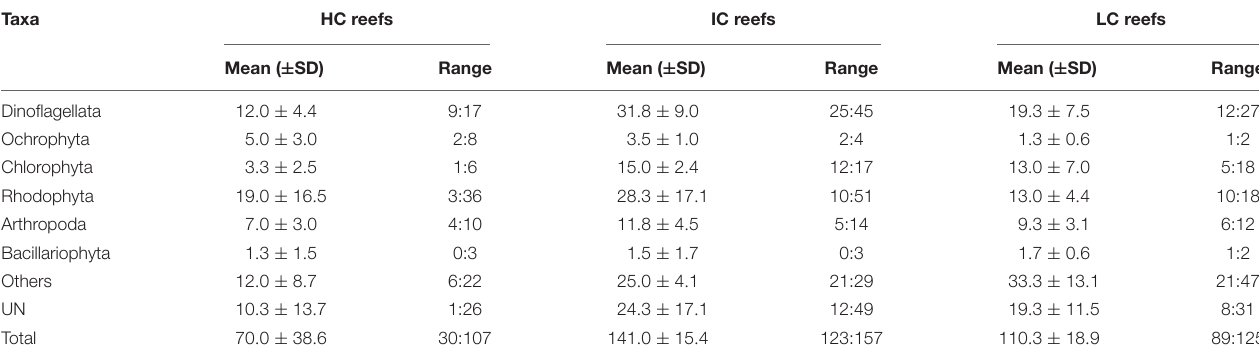
FIGURE 5 | Ordination results of (A) redundancy analysis (RDA) and (B) non-metric multidimensional scaling (NMDS). RDA was based on the relative read abundance of food taxa DNA and different substrate-type coverage. NMDS was based on a presence/absence matrix of stomach content genera. Sites with the same colors represent similar benthic conditions. The green points indicate high coral cover reefs, the red points indicate low coral cover reefs and the orange points represent sites from reefs with intermediate coral cover. TABLE 3 | Number of operational taxonomic units (OTUs) detected in the stomach contents of Ctenochaetus striatus from different